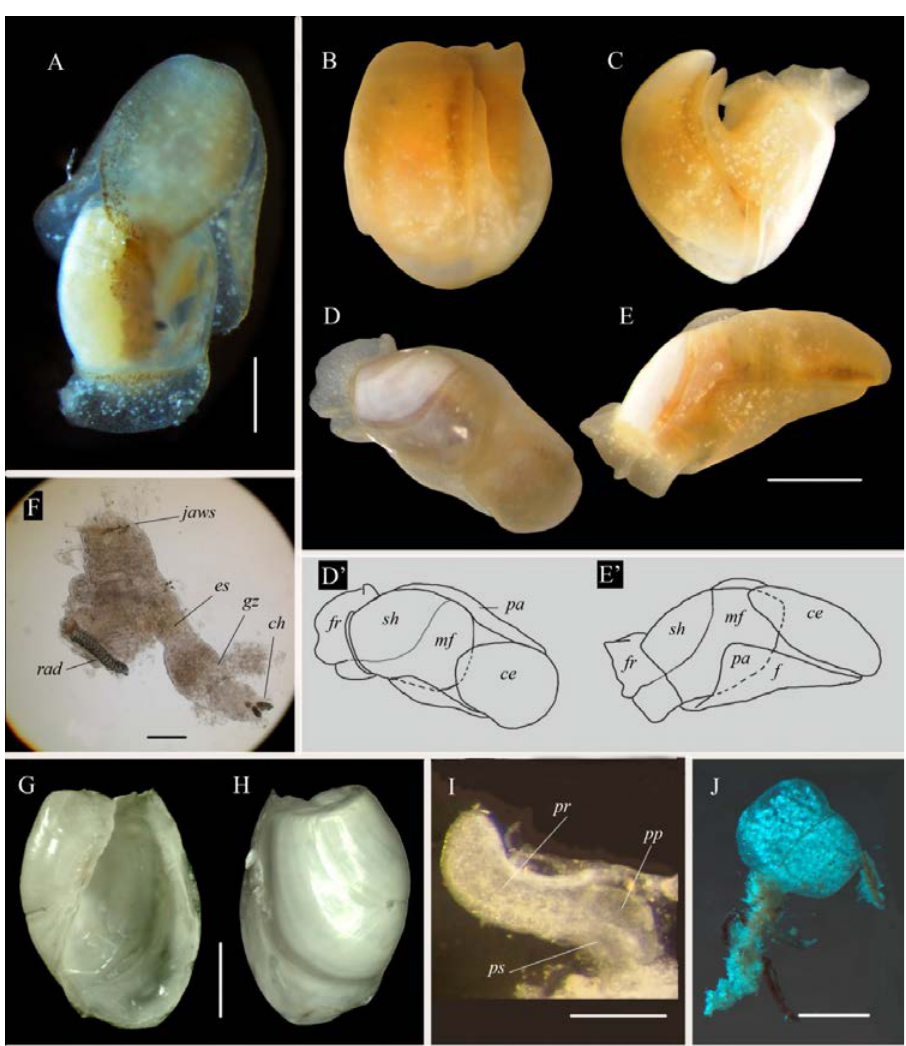
Figure 2. Philinissima denticulata specimens from the White Sea: ( A , D )—dorsal view; ( B – E )—moving specimen; ( E )—lateral view; ( D’ , E’ )—diagrams of figures ( D ) and ( E ) accordingly; ( B , C ), and ( D ) are the same specimen as ( E ); ( F )—anterior part of digestive system; ( G )—shell, ventral view; ( H )—shell, dorsal view; ( I )—copulatory system; ( J )—egg mass of P. denticulata spawned in the aquarium. Abbre- viations: ce—cephalic shield; ch—chitinous zones of gizzard, es—esophagus; f—foot; fr—mantle frill;